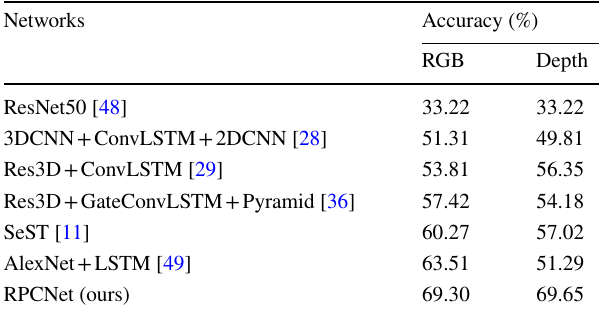
Table 6 Comparison results of our models with other state-of-the-art methods on the test set of IsoGD [14] dataset Networks